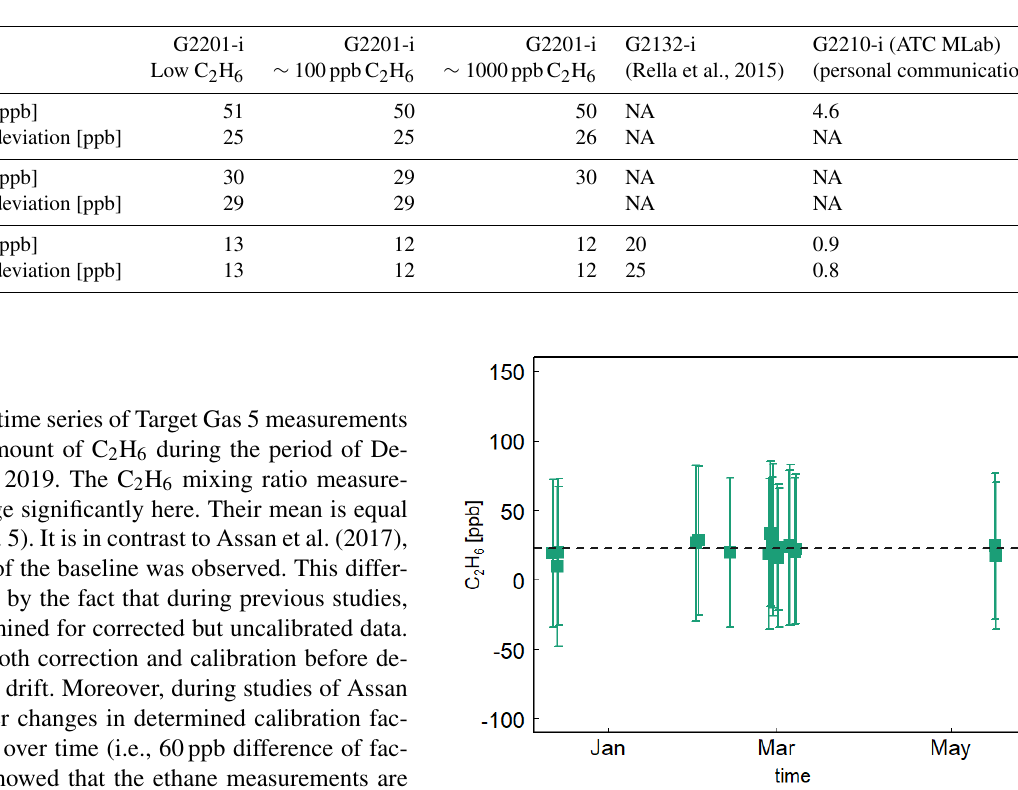
Figure 4. Allan deviation for corrected and calibrated C 2 H 6 . (a) Measurement of working gas with ambient C 2 H 6 mixing ratio (Target Gas 3), (b) measurement of the mixture of working gas with ∼ 100ppb of C 2 H 6 (mixture of Target Gas 2 and 3). Table 4. CMR and Allan deviation for G2201-i G2132-1 and G2210-i. NA – no data from the test are available.